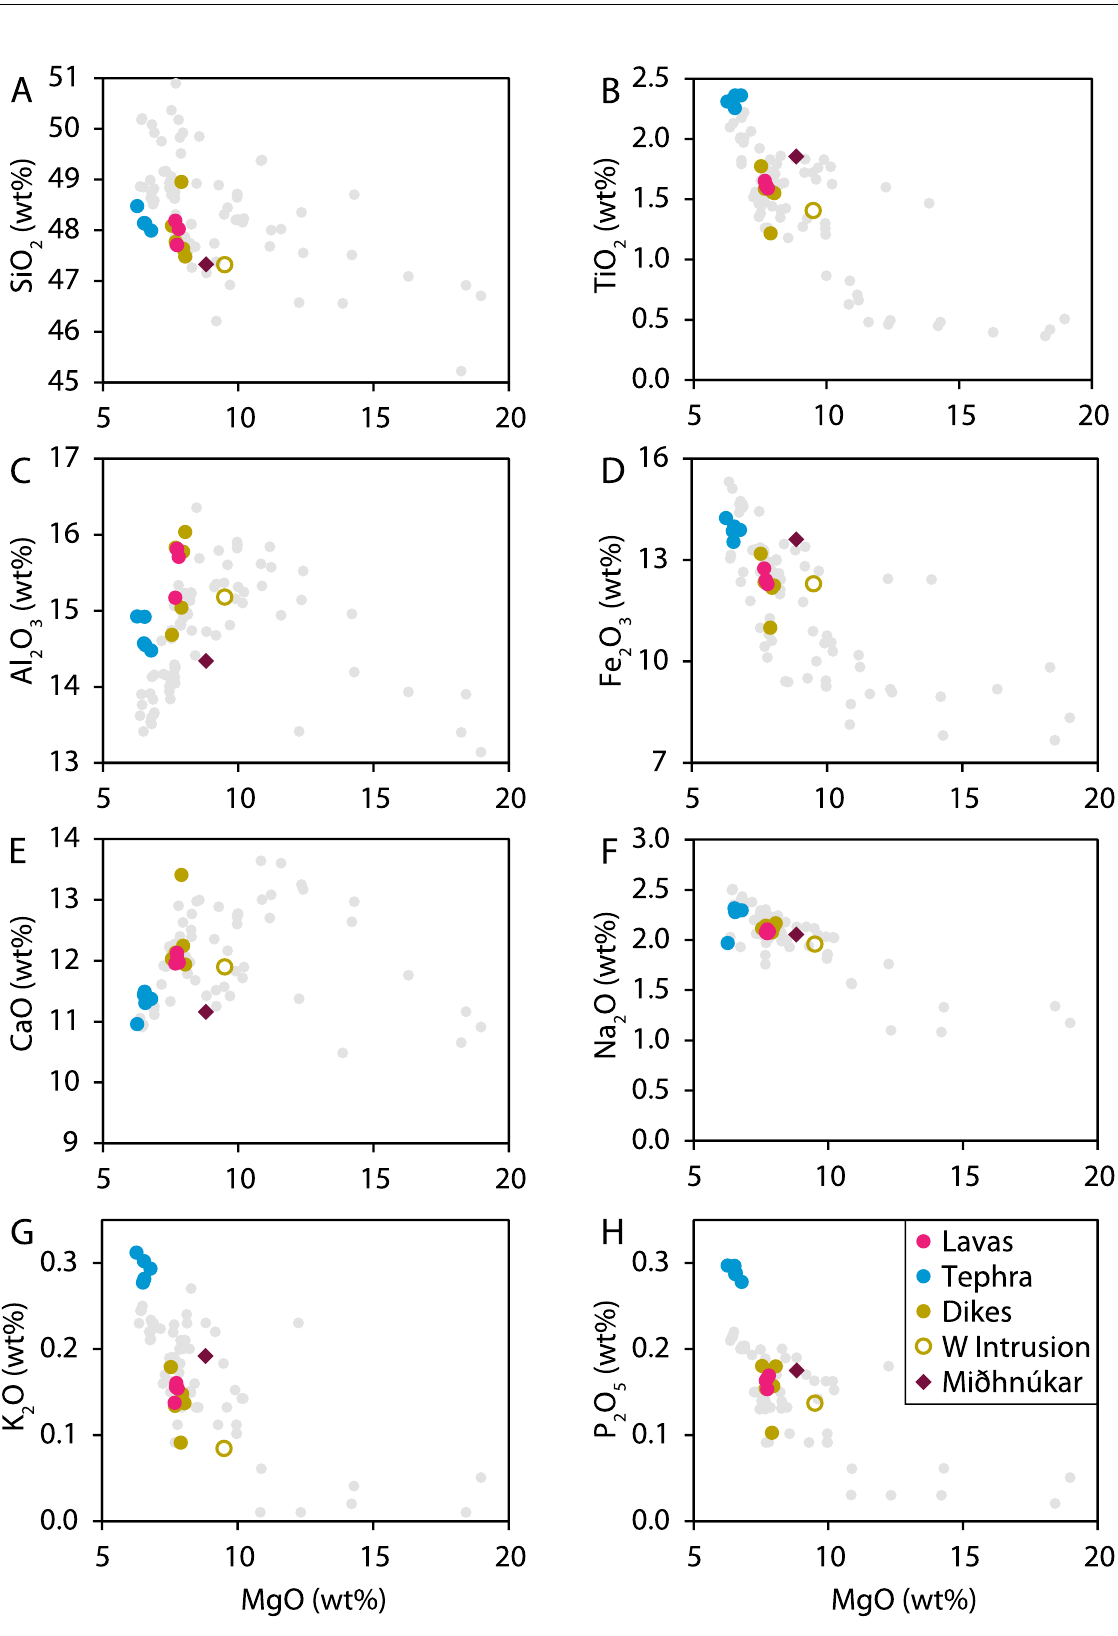
[A], TiO [B], Al O [C], Fe O [D], CaO [E], Na O [F], K O [G], and 2 2 2 3 2 3 2 2